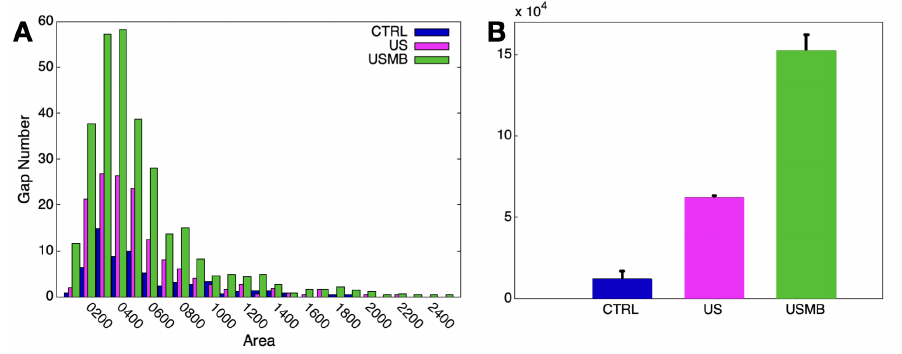
Figure 9. Histograms of gap area frequency distribution ( A ) and total gap area ( B ) for each tested condition (control, US alone and